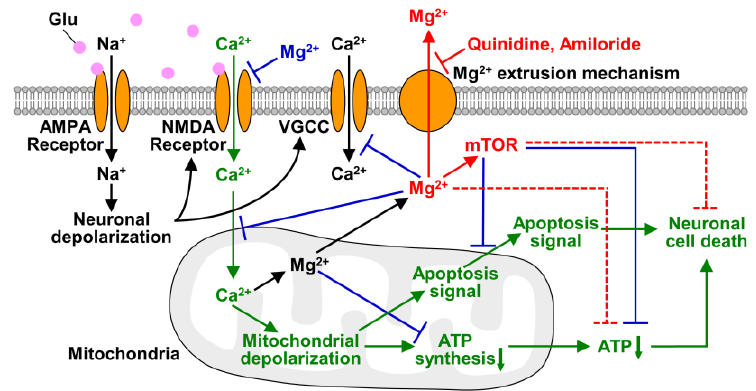
Figure 7. Schematic of roles of Mg 2 + in excitotoxicity. The transport and e ff ects of Mg 2 + and mTOR demonstrated in this study are shown in red. In this study, we demonstrated that glutamate stimulus induces not only Mg 2 + released from mitochondria but also Mg 2 + extrusion from the cytosol, and quinidine and amiloride inhibit it. Maintaining Mg 2 + in neurons suppressed glutamate-induced decrease in cellular ATP level and also attenuated neuronal cell death via mTOR signaling pathway. Dotted lines indicate pathways that are still obscure whether they are direct or indirect e ff ects. The e ff ects of Mg 2 + demonstrated previous studies are shown in blue, and the main excitotoxic signals are shown in green.